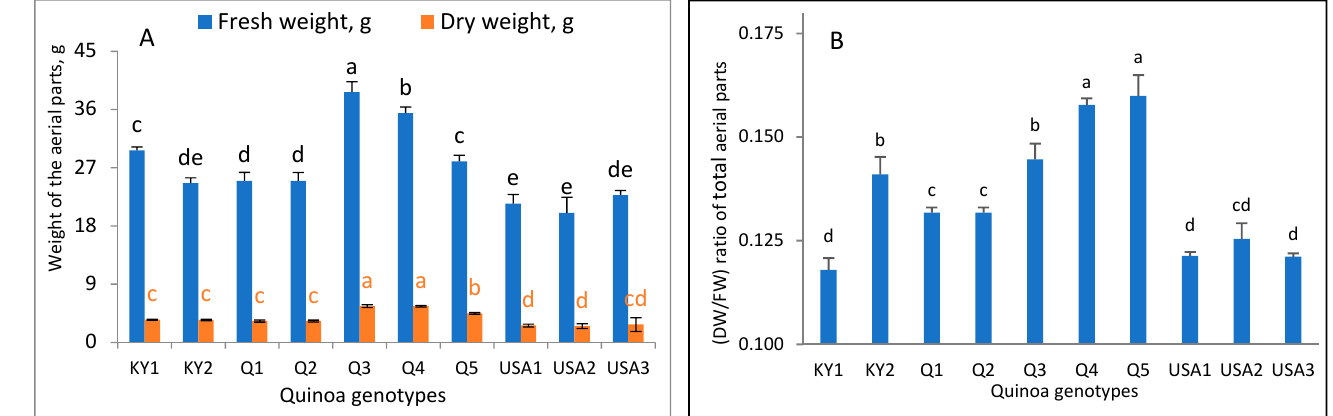
Figure 2. ( A ): The fresh weight and dry matter of the above-ground parts of the quinoa genotypes; ( B ) DW/FW ratio of the whole aerial parts of the quinoa genotypes. The same letter(s) statistically not different ( p < 0.05).